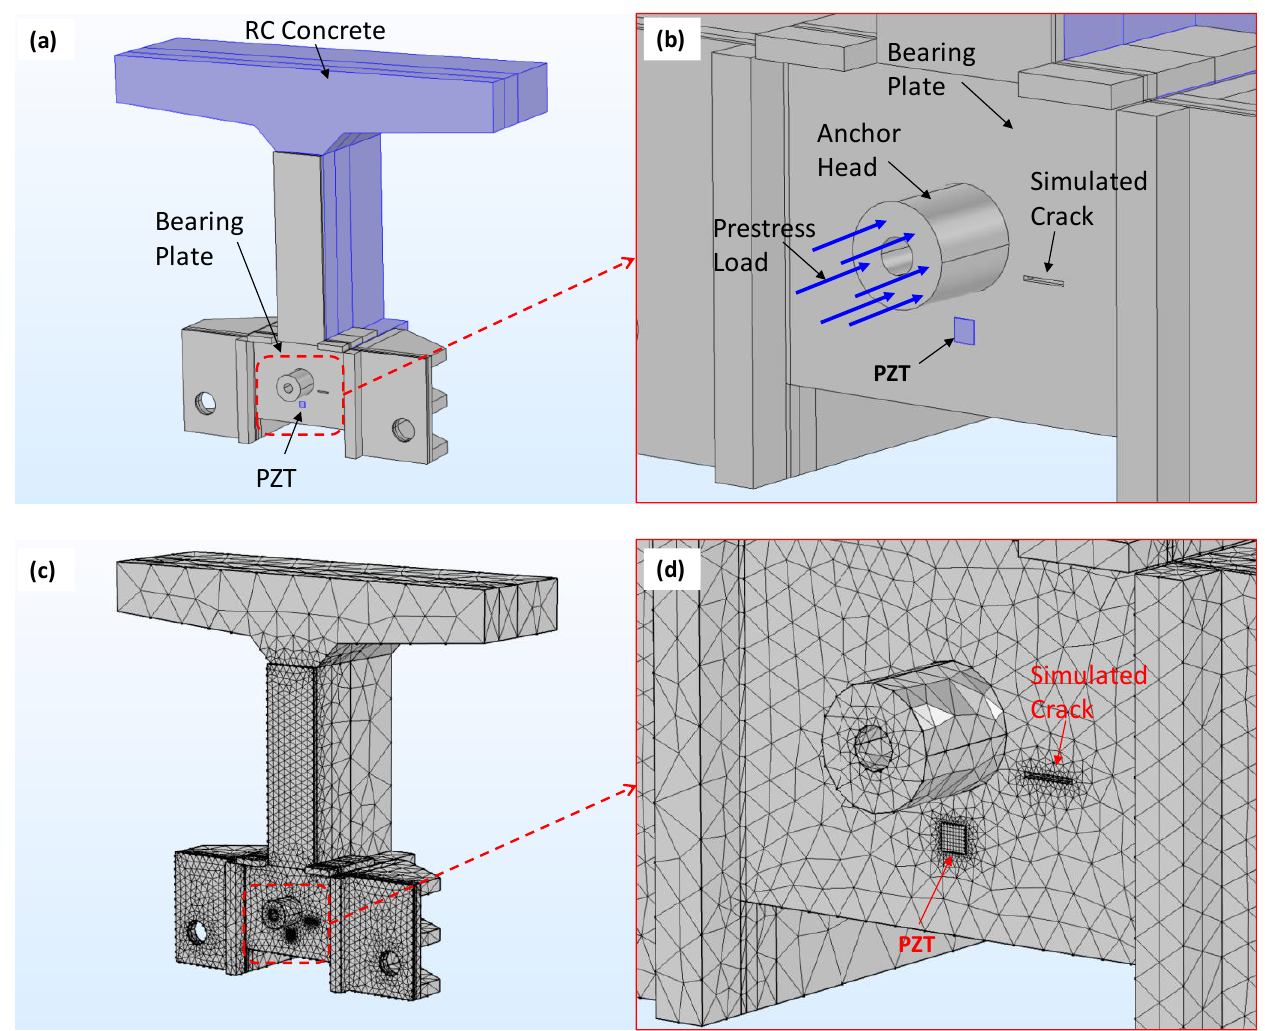
Figure 4. 3D simulation of the PZT–anchorage subsystem: ( a ) FE model; ( b ) anchorage; ( c ) meshed FE model; ( d ) meshing at anchorage. Table 1. The mechanical properties of the structural elements in the FE model. Steel Anchor Head Parameters Symbols